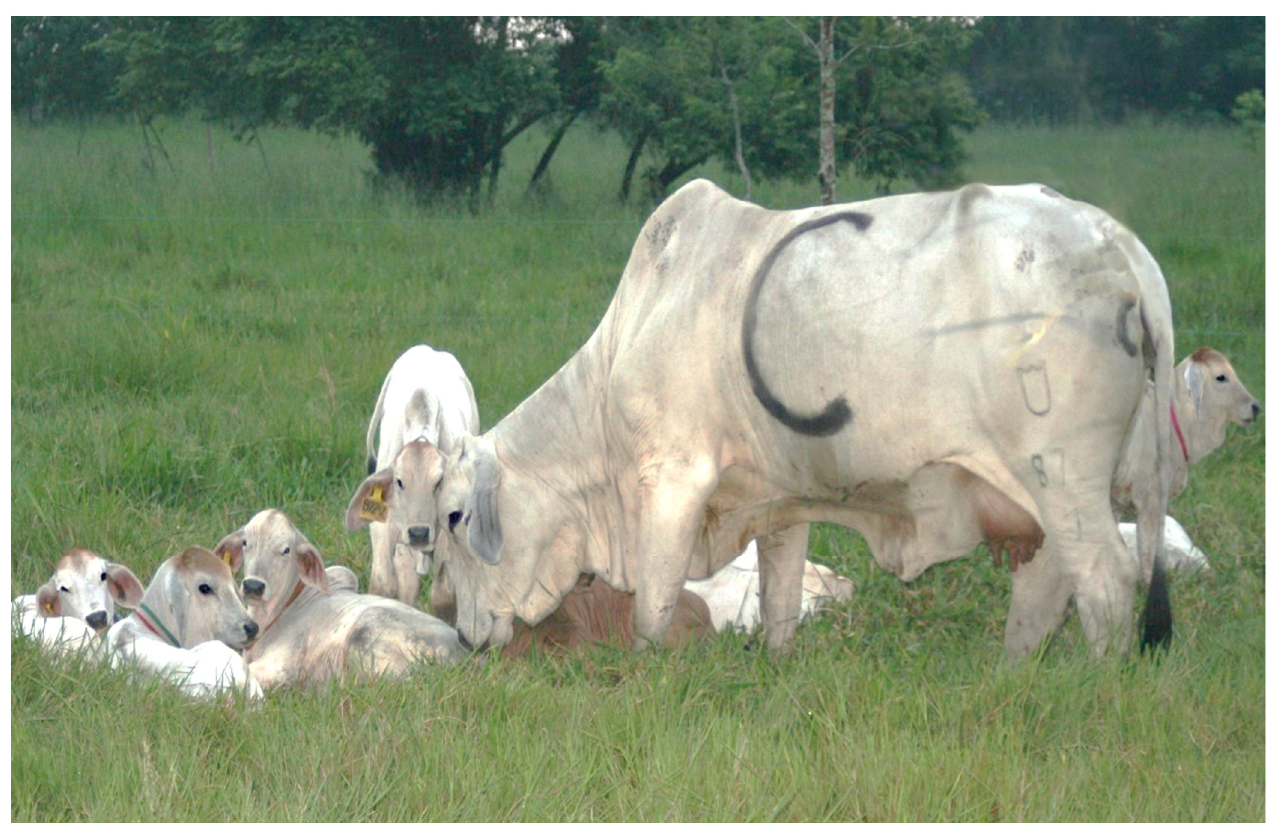
Figure 1. In extensive livestock production, it has recently been shown that specific cows of the herd take care of groups of zebu ( Bos indicus ) calves while their mothers graze [22].